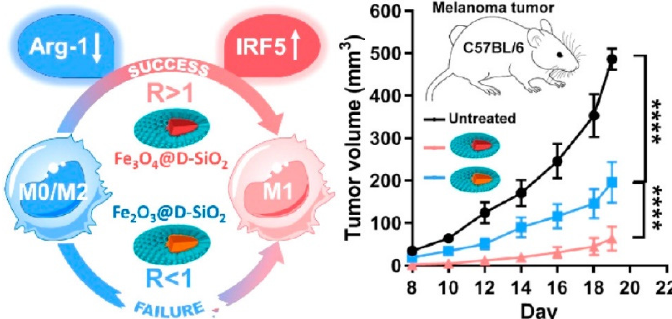
Figure 9. Schematic diagram representing MNP-mediated macrophage polarization for antitumor immunotherapy. ( a ) OVA antigen-loaded iron oxide nanoparticles modulate M2 macrophage polarization to M1 macrophages and stimulate T-cell proliferation. ( b – i ) Physiological characterization (TEM, SEM and elemental mapping of the IO-LPMON). Repro- duced with permission from [106] published by John Wiley and Sons, 2021.